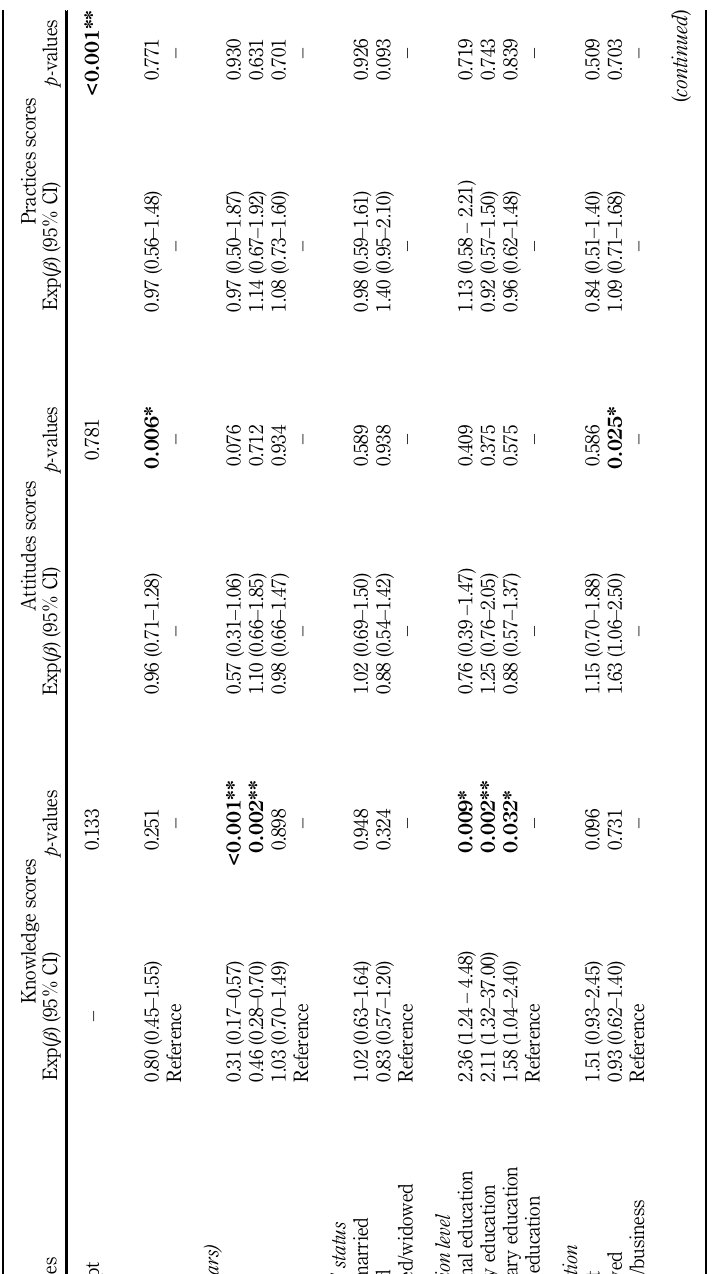
Table VI. Details of